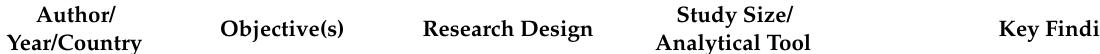
Table 1. Description of the studies included in the systematic